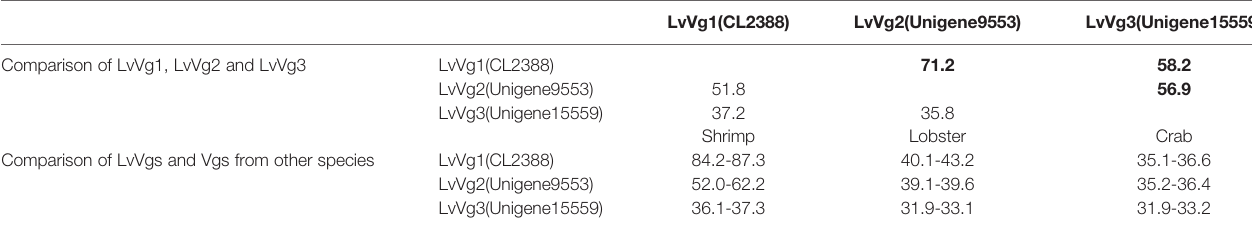
TABLE 1 | Comparison of LvVg1, LvVg2, LvVg3, and other Vg